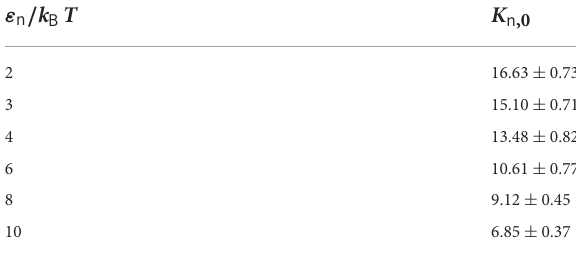
TABLE 1 Values for the equilibrium constant K n,0 determined by curve-fitting Equation 12 to the simulated data for various values of the dimerisation energy ε n